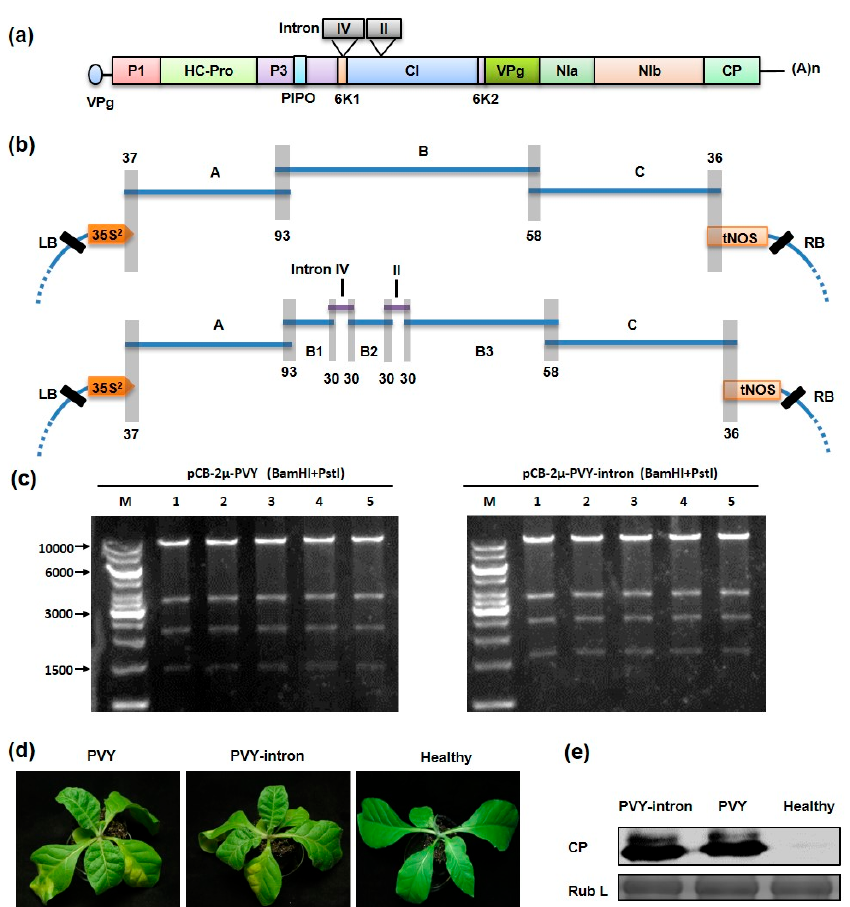
Figure 3. One-step assembly of intron-less and intron-containing potato virus Y (PVY) infectious cDNA clones by homologous recombination in yeast: ( a ) PVY genome structure. The 5’ viral protein genome-linked (vpg) and the 3 ′ polyadenylated tail [(A)n] are depicted. The positions of two inserted introns are indicated on the top of the genome; ( b ) Schematic representation of the cloning strategies for yeast homologous recombination-mediated assembly of the PVY intron-less (upper panel) and intron-containing (lower panel) full-length clones. The intron-less PVY clone was assembled by co-transformation of yeast cells with the three overlapping PVY cDNA fragments (A, 3311 bps; B, 3359 bps; C, 3259 bps) and the appropriately linearized vector pCB301-HDV-2 μ . For the intron-containing clone, the B fragment is divided into three fragments (B1, B2 and B3) by insertion of the two inserted intron (IV and II). The overlapping regions are depicted by gray boxes, with the number of overlapping nucleotides indicated. Note that all of the fragments in the figure are not drawn exactly to scale; ( c ) Recombinant plasmids were digested with BamHI and PstI and the products were separated on 0.8% agarose gels. The positions of the 10,000, 6000, 3000 and 1500 bp size markers (M) are indicated to the left of the panel; ( d ) Nicotiana tabacum plants systemically infected with the intron-less or intron-containing PVY infectious clone were photographed at 15 days post infiltration. Healthy: an uninfected plant; ( e ) Total proteins extracted from PVY infected plants were analyzed by Western blotting using an antibody against the PVY CP protein. The Coomassie blue-stained Rubisco large subunit (Rub L) is used as a loading control.